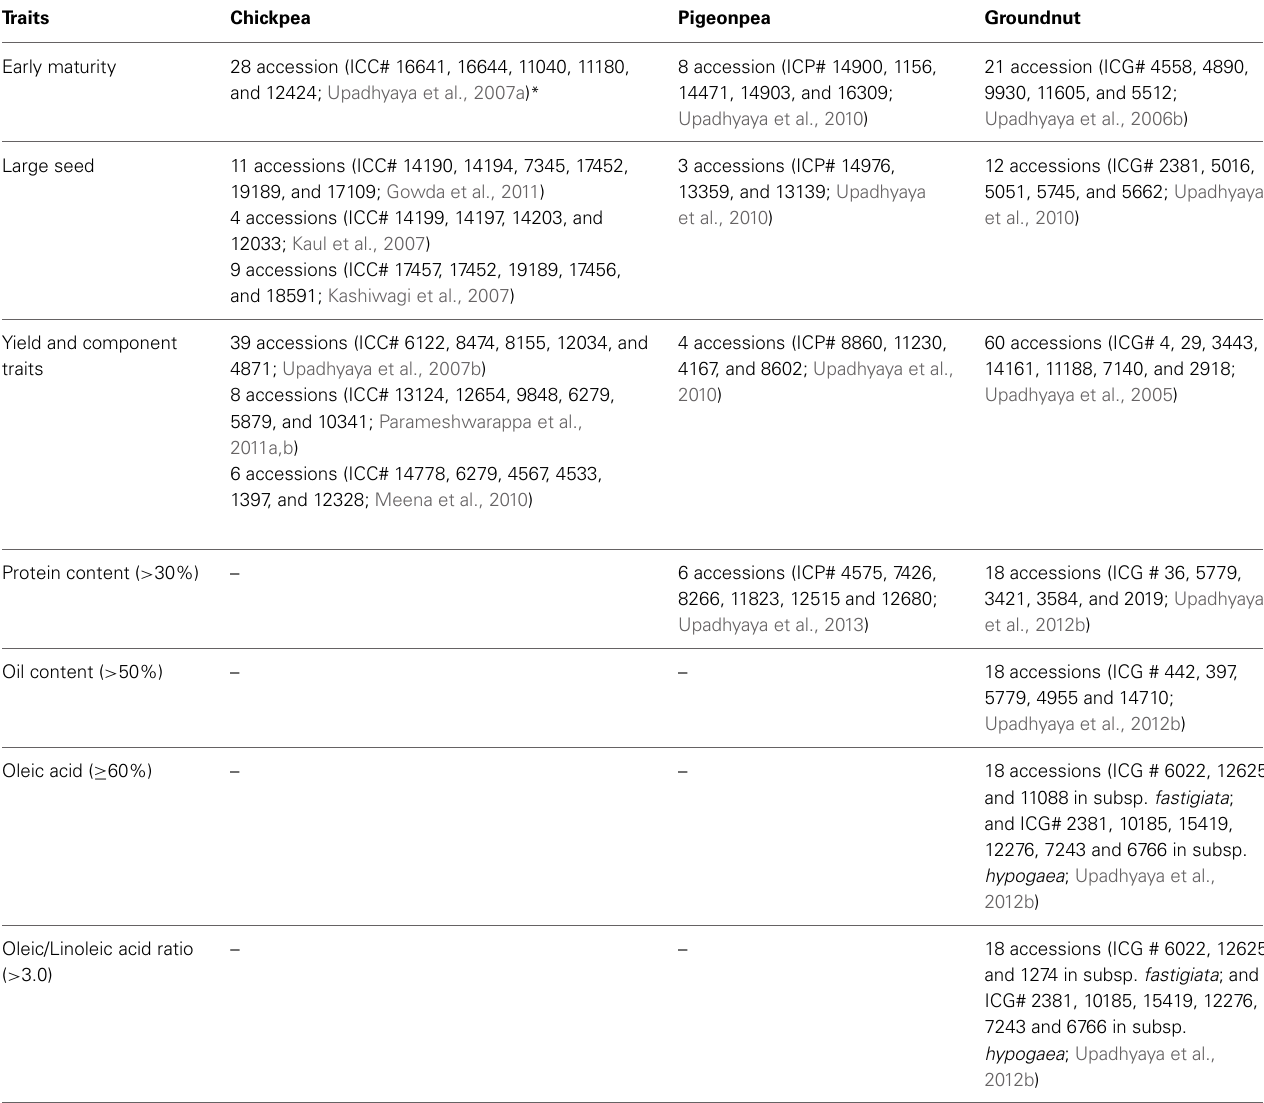
Table 3 | Promising germplasm accessions for agronomic and nutrition-related traits in chickpea, pigeonpea and groundnut.